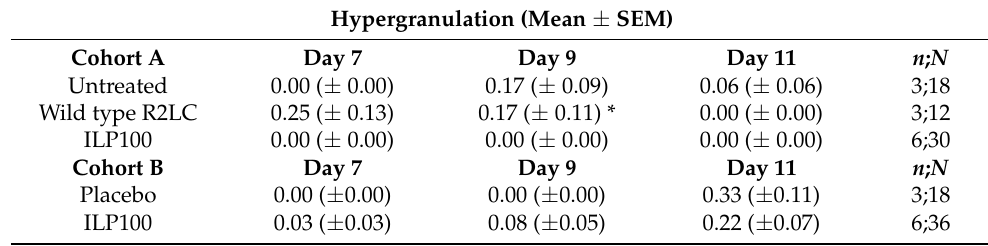
Table A5. Average score (0–4) for hypergranulation for untreated wounds, wounds treated with wild type L. reuteri R2LC or ILP100 in Cohort A and wounds treated with placebo or ILP100 wounds in Cohort B. For time points not included in the table, all wounds in all groups were scored as 0. * p <